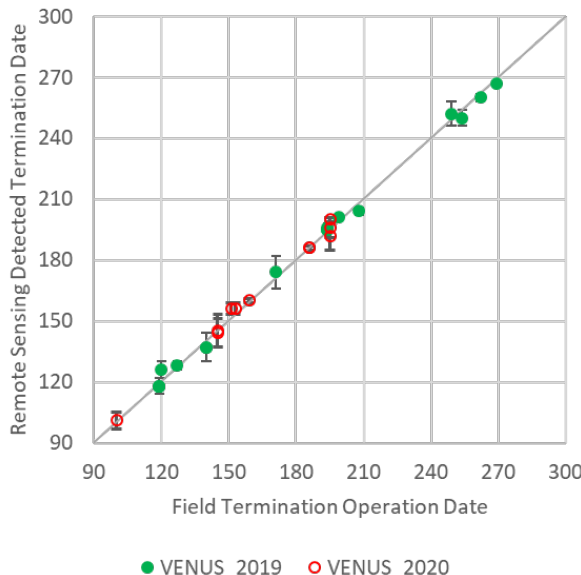
Figure 8. Scatter plot of the detected termination dates for fields at the BARC in 2019–2020 using the VENµS NDVI time-series and the recorded harvest/termination operation dates. The vertical bar shows the uncertainty of the remote sensing estimated termination date.